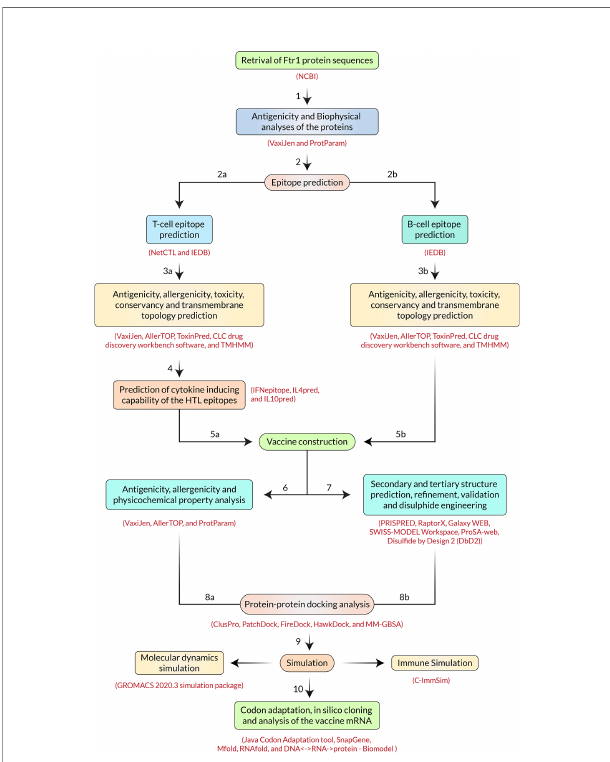
FIGURE 2 | Step-by-step procedures used in the vaccine constructing